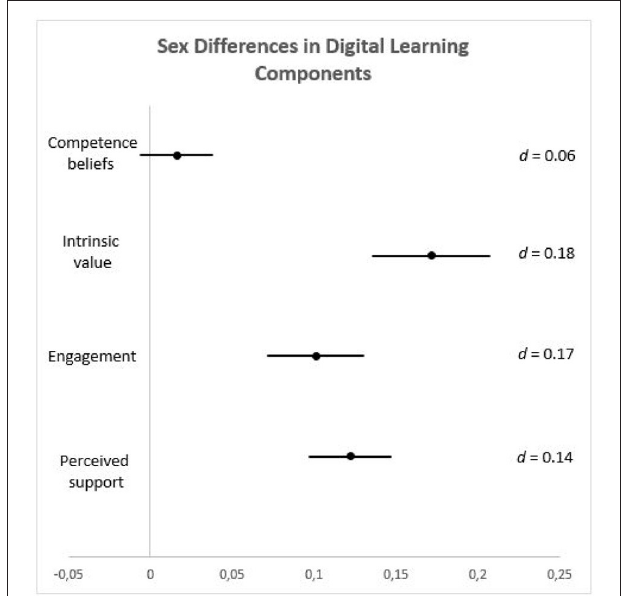
FIGURE 1 | Mean differences and two-sided 95% confidence intervals for boys and girls in four digital learning components. The x-axis shows the confidence interval span. The point estimate is the mean difference between boys and girls in observed digital learning components. Cohen’s d indicates effect size for the comparison between two means. Positive values indicate advantage of girls over boys in observed digital learning